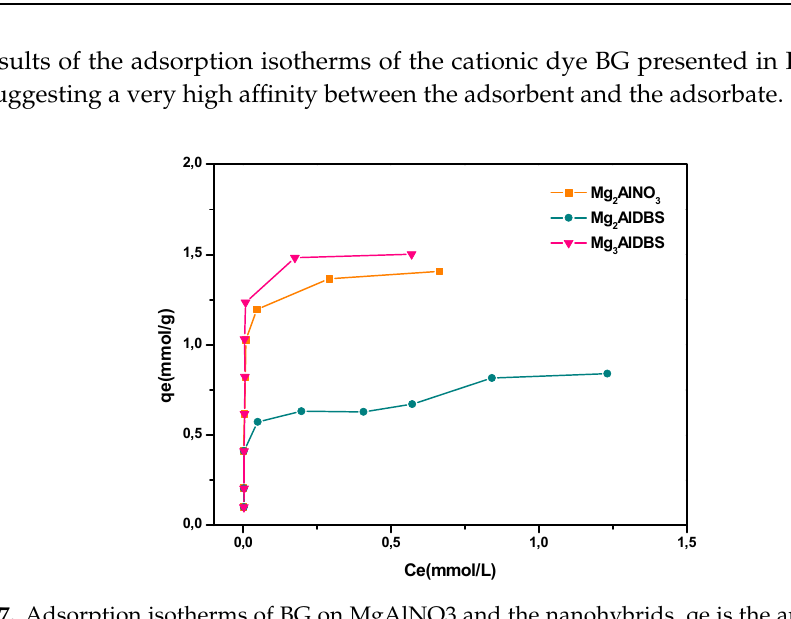
Figure 7. Adsorption isotherms of BG on MgAlNO3 and the nanohybrids, qe is the amount of dye adsorbed at equilibrium (mmol · g − 1 ).